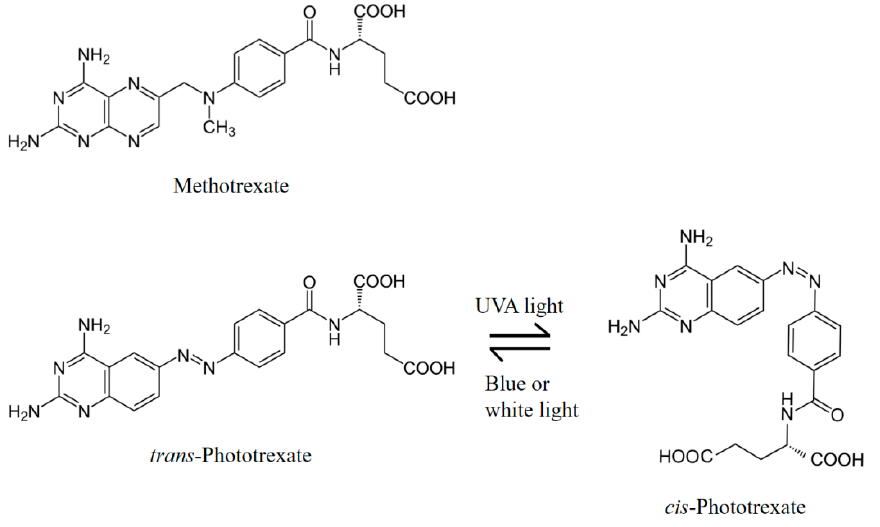
Figure 1. Chemical structures of methotrexate (MTX), trans -phototrexate ( trans -PHX), cis -phototrexate ( cis -PHX), and the reversible isomerization of PHX [6].